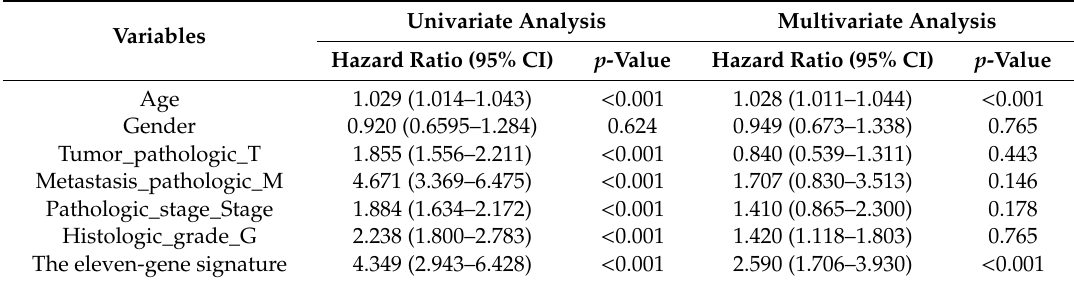
Figure 9. Kaplan Meier survival and ROC curves based on the risk score of the combined five transcription factors and six miRNAs as a signature. ( A ): Overall survival curves for high-risk and low-risk groups based on the prognostic model of an eleven-gene signature; and, ( B ): ROC curves for high and low risk from the prognostic model of an eleven-gene signature. Table 2. Univariate and multivariate Cox regression analysis of overall survival for clinical factors and risk of the combined five prognostic transcription factors and six miRNAs as a